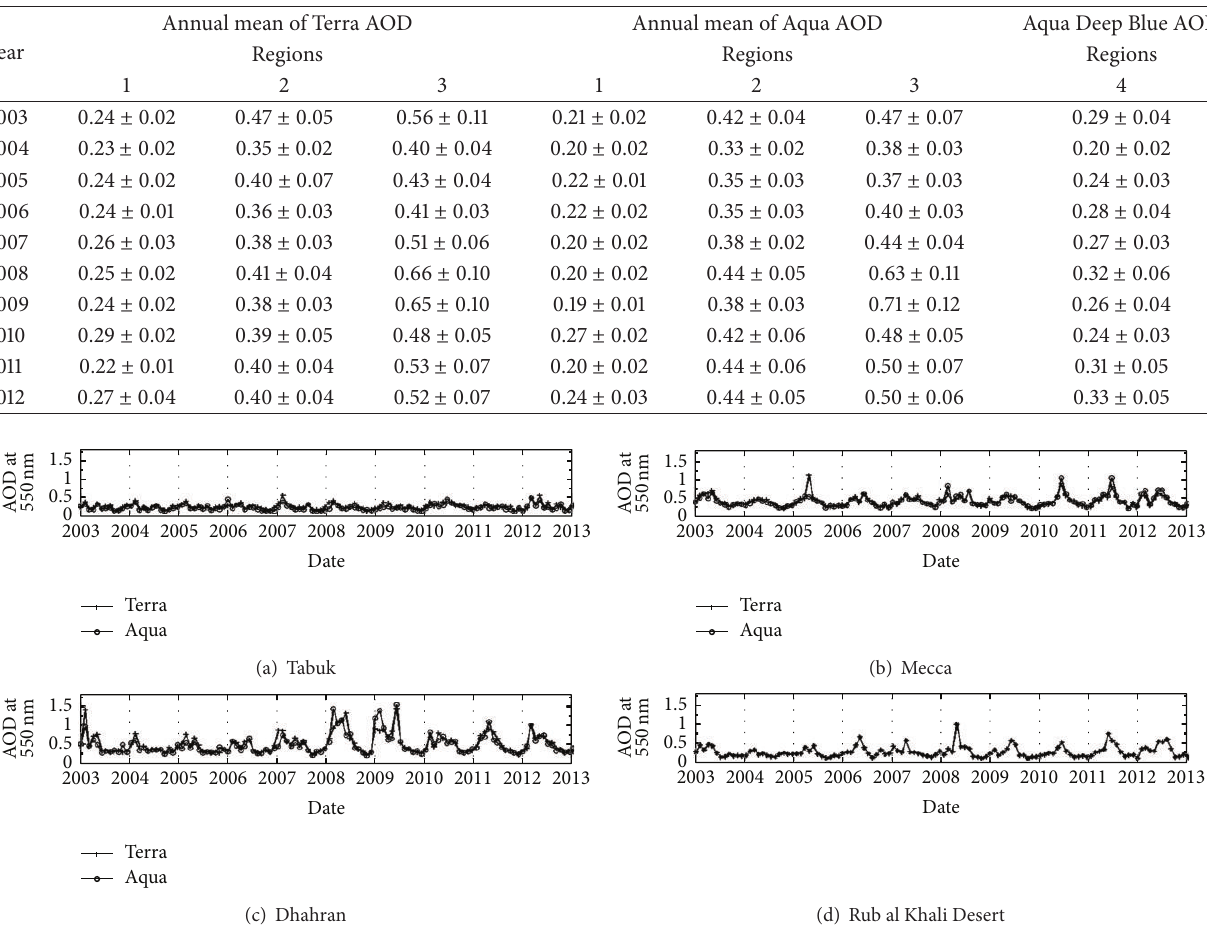
Figure 2: Time series plot of MODIS AOD at 550 nm using Terra and Aqua over (a) Tabuk, (b) Mecca, and (c) Dhahran and Aqua Deep Blue data over (d) Rub al Khali (Empty Quarter)